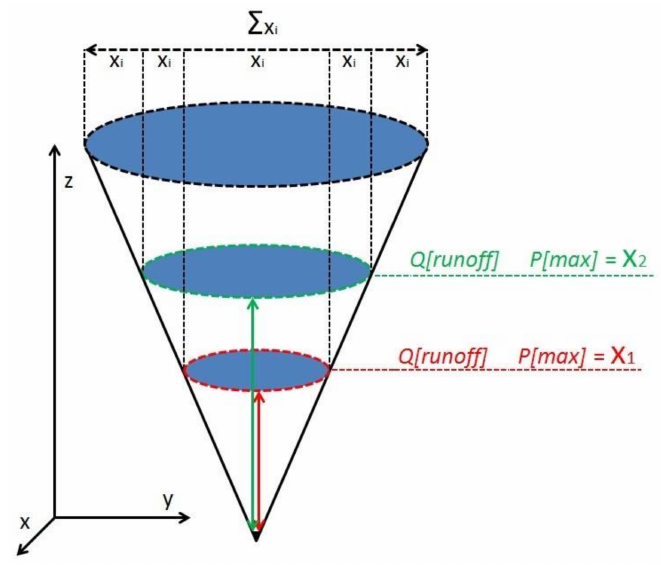
Figure 2. A representation of the relation between flooded area and amount of